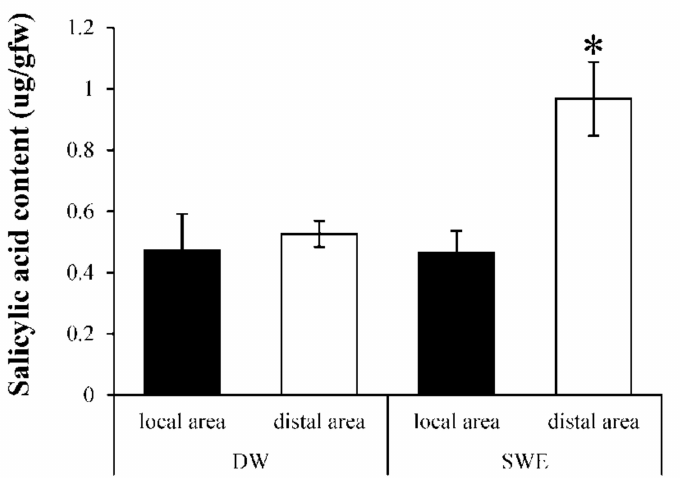
Figure 6. Salicylic acid (SA) contents in SWE-treated leaves. The black bars refer to SA content in the lower leaves (local area) sprayed with SWE or distilled water for 24 h, and the white bars refer to SA content in untreated upper leaves (distal area) of each set. Data were presented as mean ± S.E. (n = 3). Statistical analysis was performed using a one-way ANOVA, taking p <